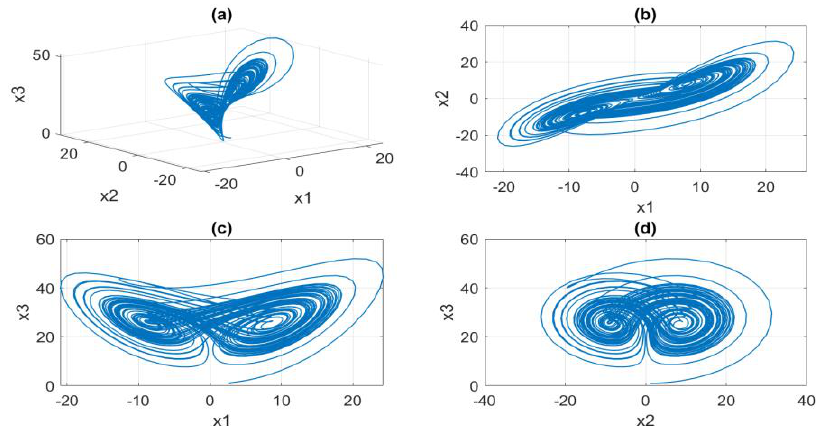
= 0.3 ( a ) x − x − x 2 3 . 1 x x − − . Figure 1. Bounded strange attractors of a unified chaotic system with α 1 2 3